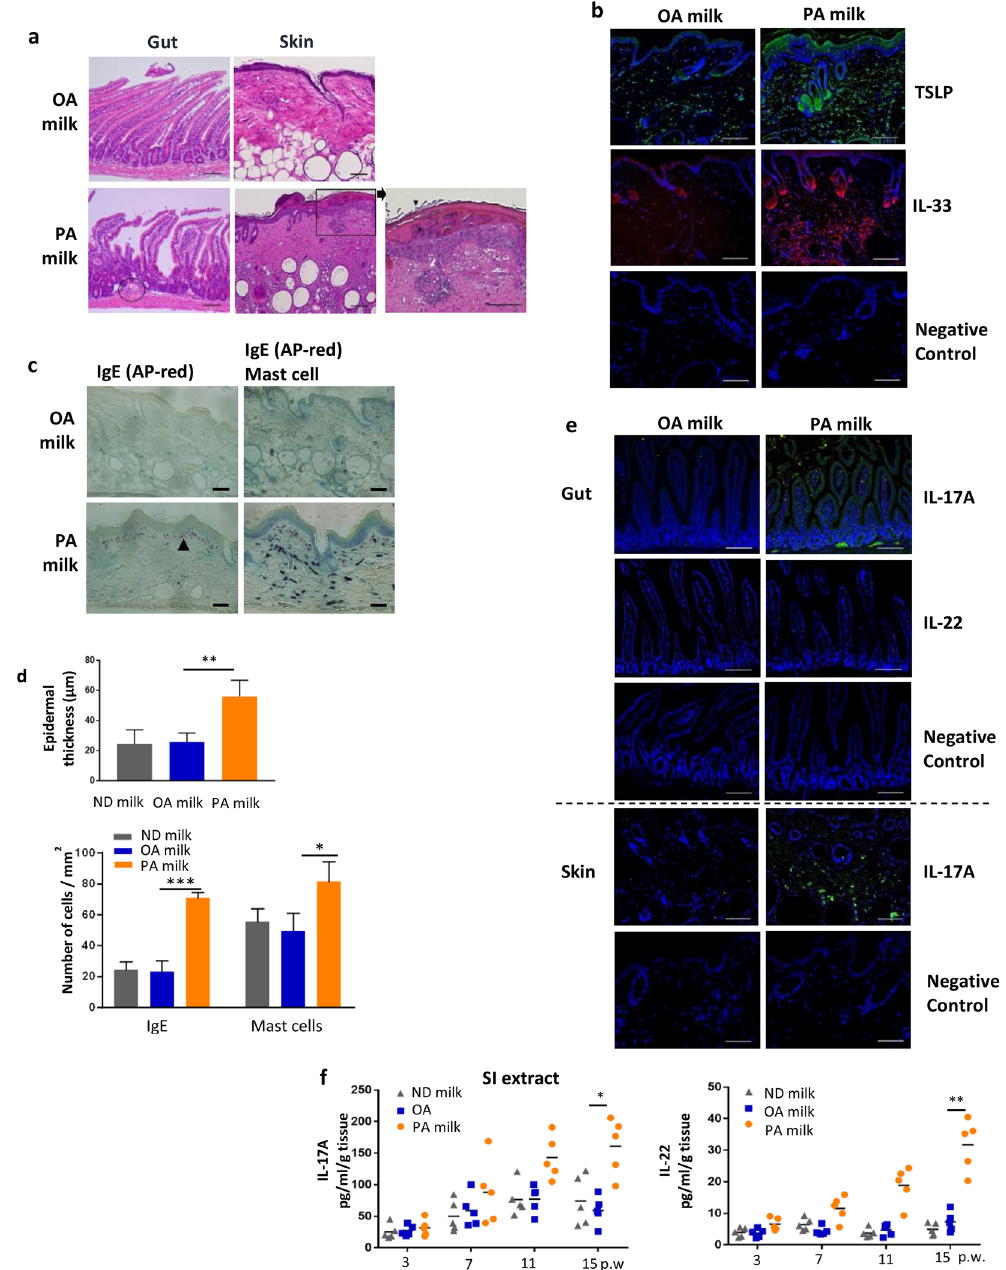
Figure 5. PA milk diet induced inflammation in the gut and skin. ( a ) Hematoxylin and eosin staining of the small intestine and skin of OA milk or PA milk mice at 15 weeks post-weaning (p.w.). Gut of PA milk mice was observed with mucosal or submucosal inflammation, accompanied with inflammatory cells infiltration (black circle). A section of the PA milk skin is enlarged showing histopathology of atopic dermatitis. Black and white arrows indicate parakerotosis and spongiosis, respectively. Asterisk indicate neutrophil containing pustule. Scale bars, 100 µm. ( b ) Representative immunofluorescence staining for TSLP and IL-33 in skin of mice at 15 weeks p.w. Scale bars, 100 µm. ( c ) Representative immunohistochemical staining of IgE (fast red chromogen) and mast cells (toluidine blue) in the skin of mice at 15 weeks p.w. Scale bars, 100 µm. ( d ) Epidermal thickness and number of IgE-stained or mast cells were calculated from 10 randomly selected areas and shown as the mean number of cells per millimeter squared ± SD (n = 3 mice/group). ( e ) Representative immunohistochemical staining of IL-17A and IL-22 (DAB chromogen and hematoxylin) in small intestine and skin of mice at 15 weeks p.w. Scale bars, 100 µm. ( f ) ELISA quantitation of IL-17 and IL-22 of small intestine (SI) tissue extracts at indicated p.w. (n = 5 mice/group). * P < 0.05, ** P < 0.01, *** P < 0.001, one-way ANOVA. Data are analyzed with Prism8 (version 8.4.3, https:// www. graph pad. com/ scien tific- softw are/ prism), and ImageJ (version 1.53, https:// imagej. nih. gov/ ij/ index.